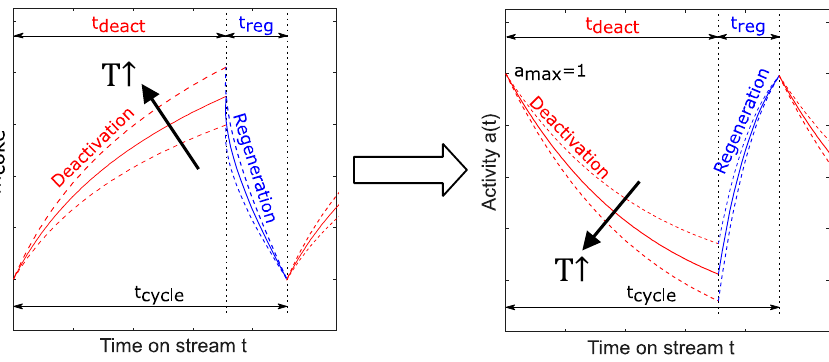
Figure 16. Scheme of coke growth ( left ) and catalyst activity ( right ) over time during produc- tion/coking/deactivation periods and regeneration/reactivation periods.